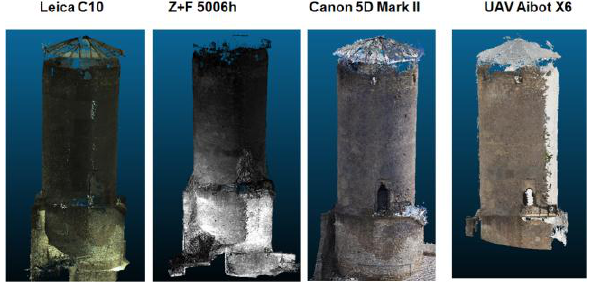
Figure 3: Point clouds acquired from different sensors